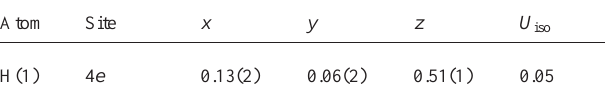
Table 2. Atomic coordinates and displacement parameters (in Å 2 )